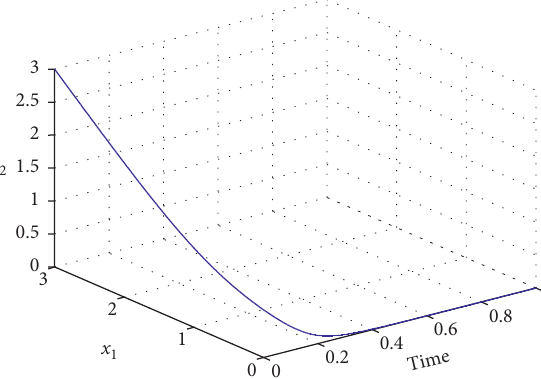
( t ) and (b) x ( t ) in system (28). 1 2